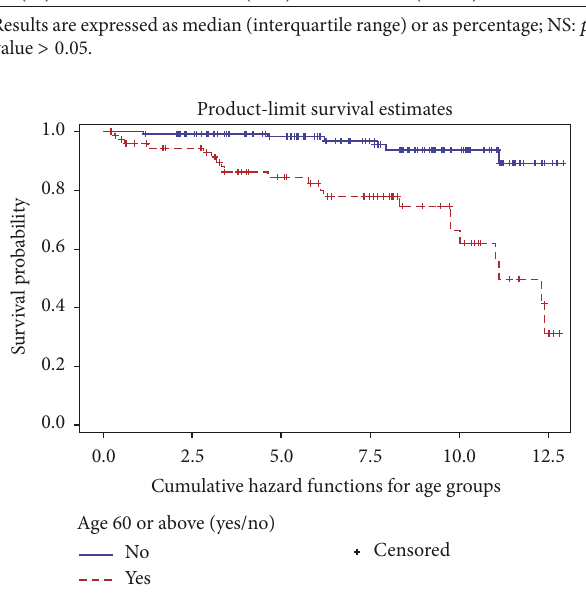
Figure 1: Malignancy-free survival in patients ≥ 60 years of age and those < 60